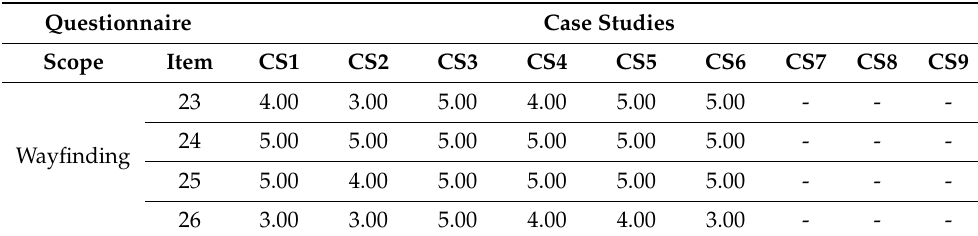
Table 12. Results (median values) of each questionnaire administered in the nine case studies, aimed at evaluating the wayfinding and signage section. Own